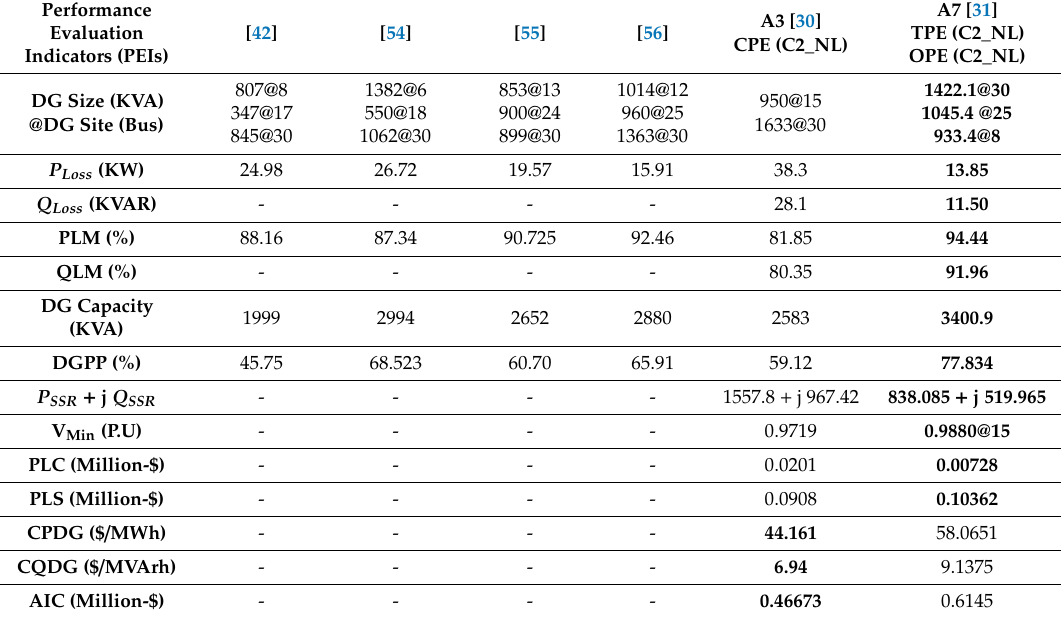
Table 31. Comparisons of results with C2_NL for 33-bus TDN (DG@LPF = 0.85).